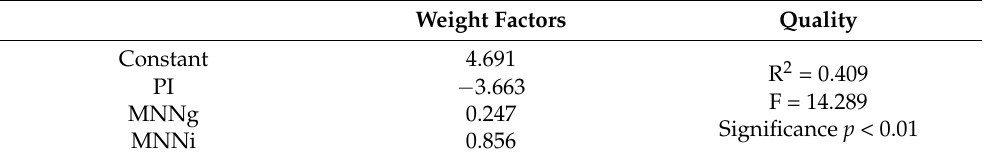
Table 9. Regression analysis results for WCI amplitude and impact factors.